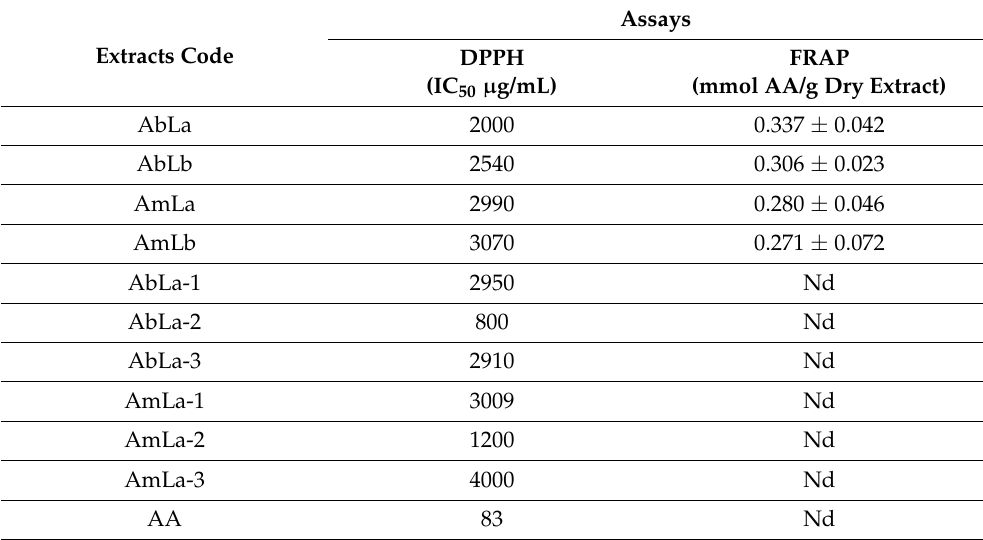
Table 3. In vitro determination of the antioxidant activity of A. bento-rainhae and A. macrocarpus leaf crude extracts and their subsequent L-L